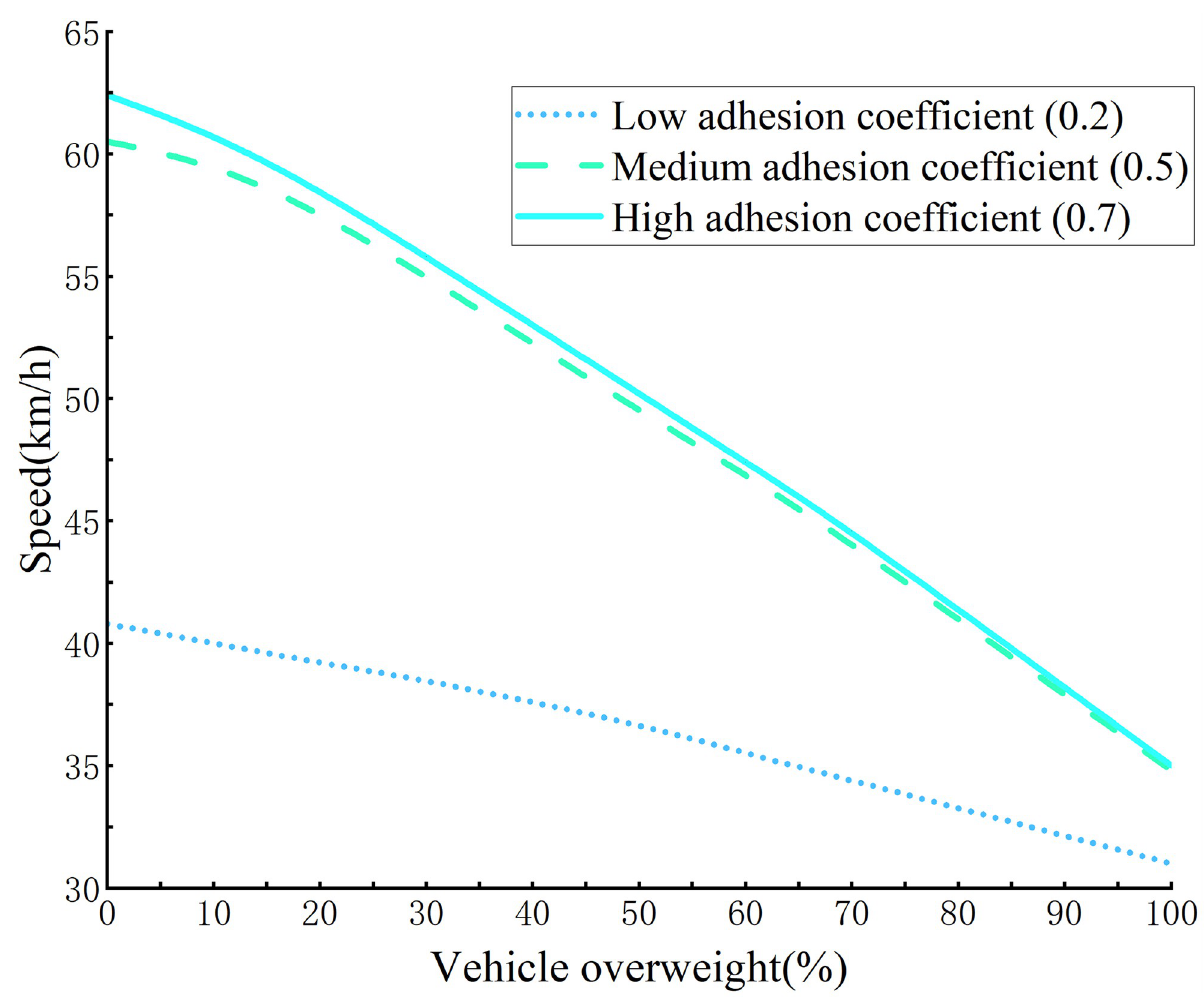
Fig 15. Curve of the instability speed threshold of truck driving corresponding to different loads. 1. The right turn lane was not specifically designed, and the design radius of the vehicle’s right turn trajectory curve small. Previous research has shown that the turning radius is the most important factor affecting the threshold of the truck’s turning instability speed, with the smaller the turning radius, the lower the instability speed threshold. Road engineering stan- dards specify minimum turning radii at different design speeds. However, most of the two roads that intersect at the actual intersection were built in different periods. When the inter- section was formed, due to terrain, features, land rights, road rights, and other factors, the designer or construction party did not have sufficient knowledge of the right-turn lane. As a result, the designer often did not establish a right-turn lane consistent with the right-turn trajectory curve, such that the actual radius of the right turn was small, which did not meet the demand for the right turn radius at the bottom of the long downhill slope. There are also some T-junctions where, although the right turning radius is sufficient, due to the non- standard pavement markings, poor visibility conditions in the triangle area, and roadside traffic management, the actual track curve radius of vehicles turning right are objectively limited. A right T-intersection turn curve example here has a design radius of 30 m, which